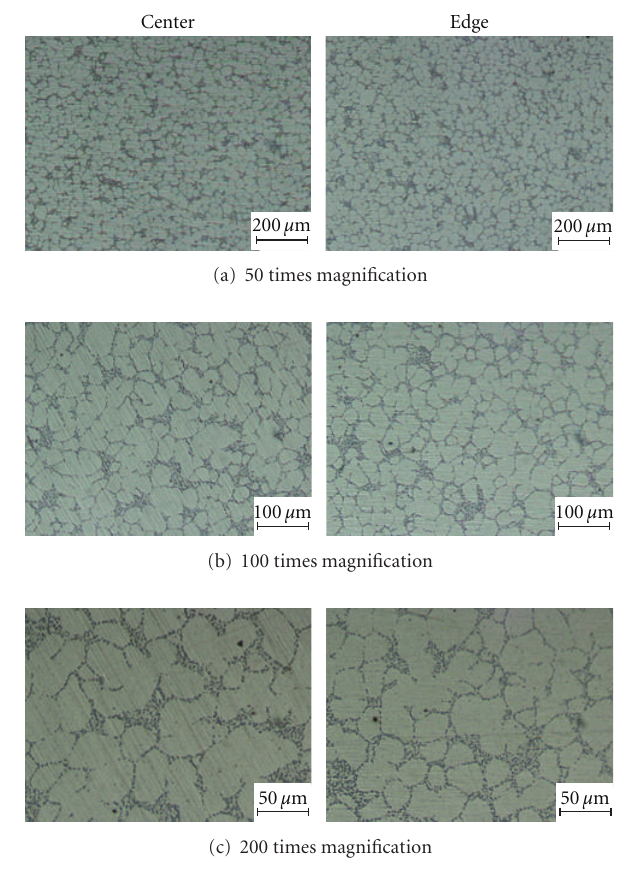
Figure 13: Microstructure of rheology material (70% solid frac-